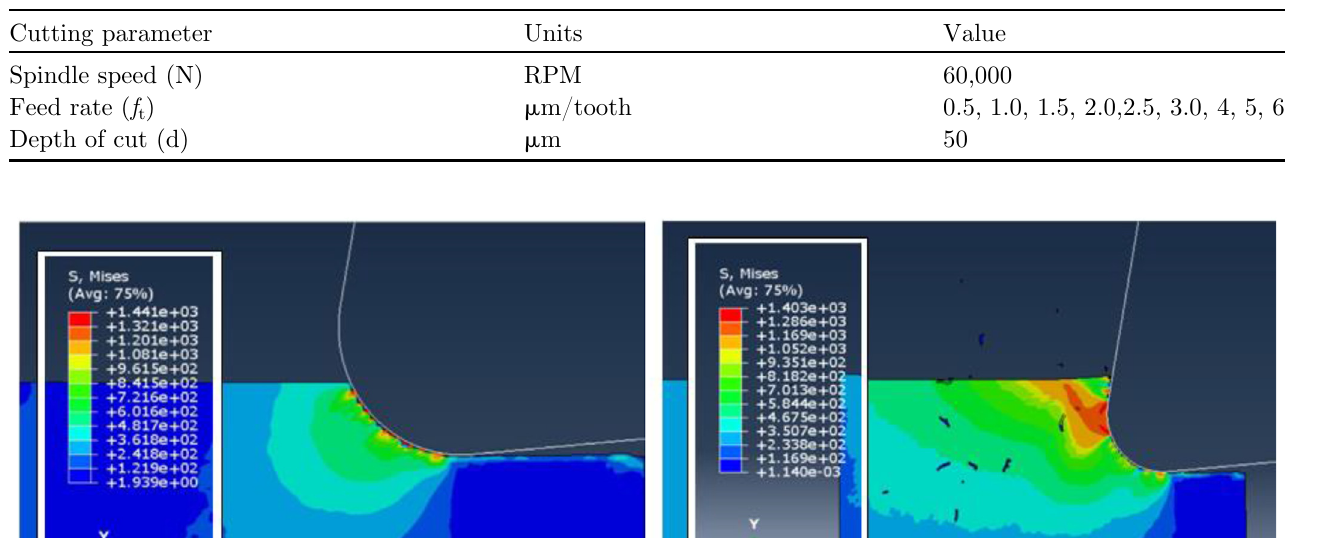
Table 3. Cutting parameters used for FEM simulation of micro end milling.